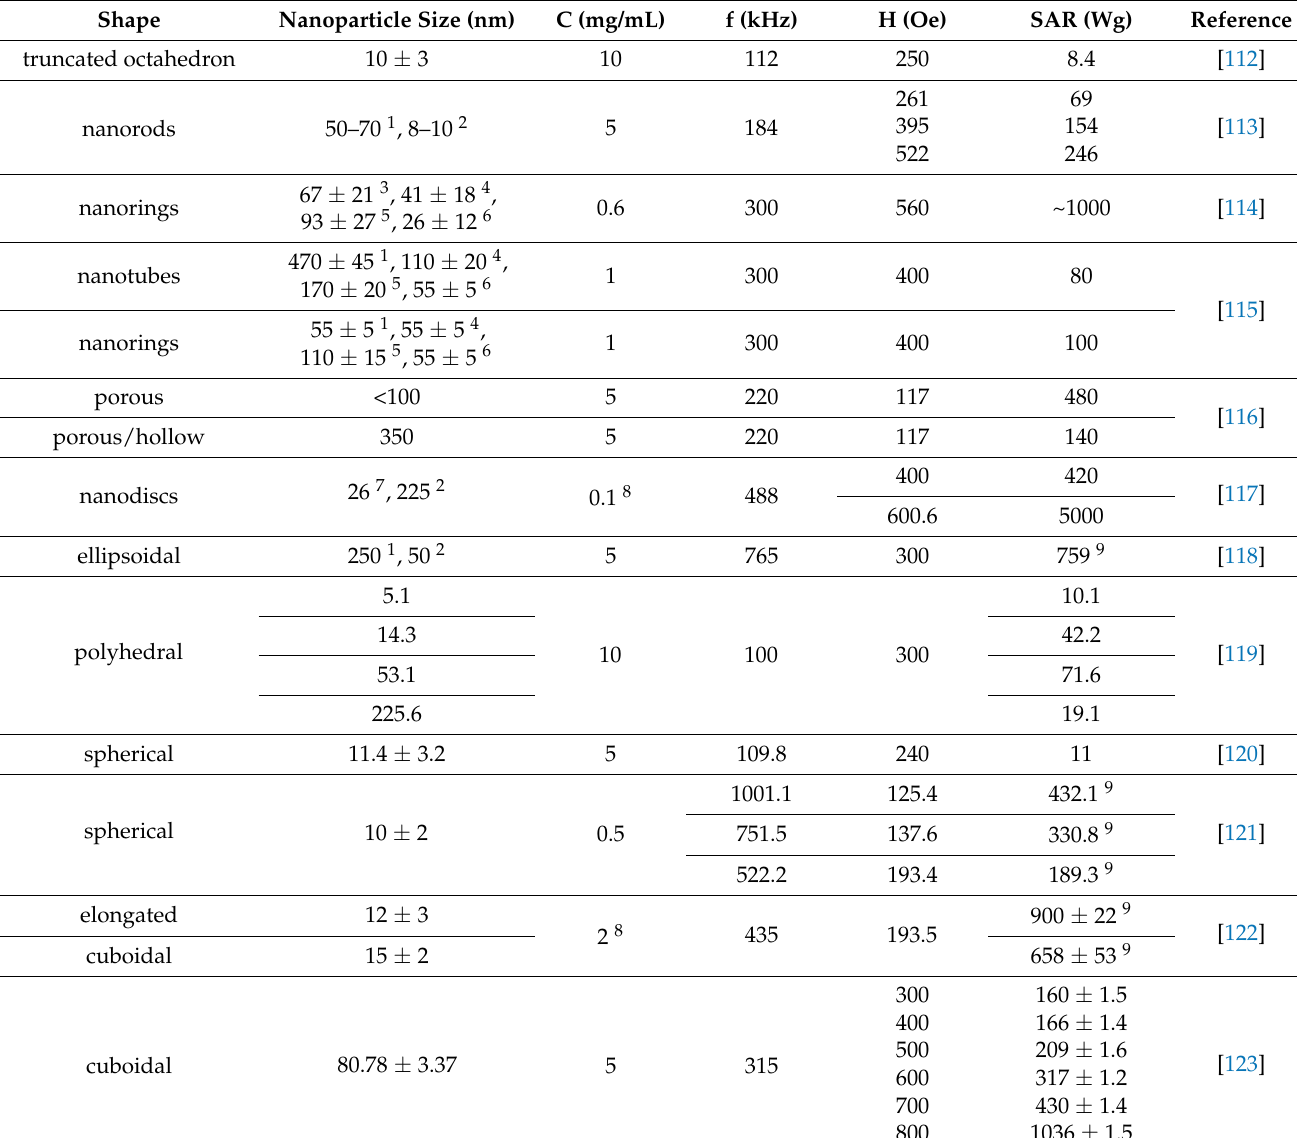
Table 2. Comparison of specific absorption rate (SAR) of magnetite nanoparticles with various shapes (C—magnetic fluid concentration, f—AC magnetic field frequency, H—magnetic field